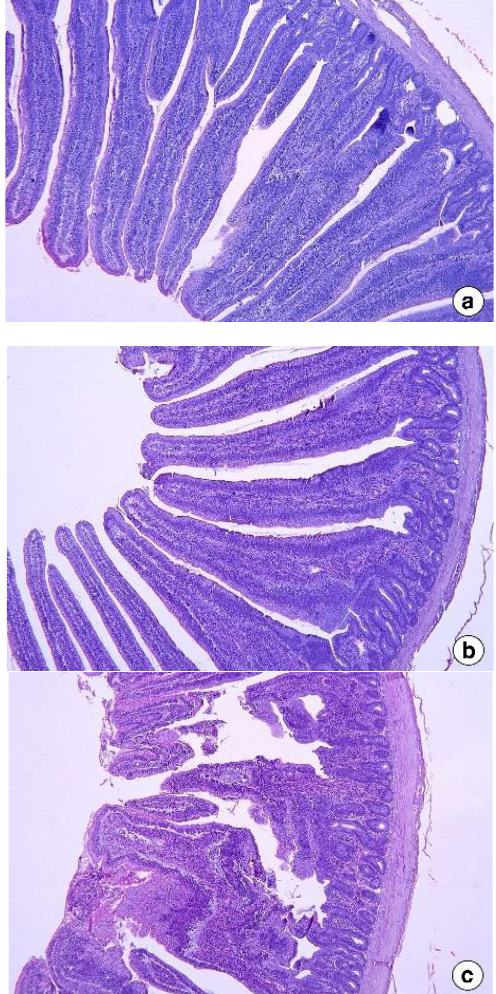
The effect of dietary inclusion of FS on the histo-morphological changes in the jeju- num and ileum of broilers is presented in Figure 1 and Figure 2, respectively. The jejunum and ileum showed inflammation with the inclusion of 5 g FS, which became more pro- nounced and prevalent with 10 g FS inclusion in the diet. Damage to the architecture of the jejunum was observed with the inclusion of 10 g FSP.